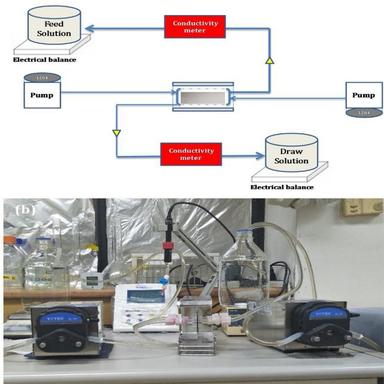
Schematic representations of FO set up for the TFN membranes performances.